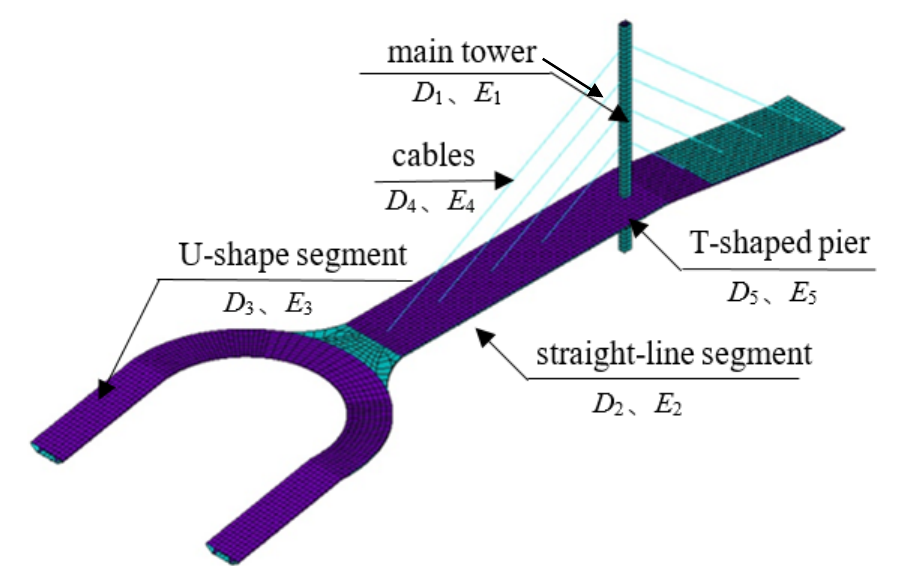
Figure 15. The finite element model (FEM) of the footbridge.